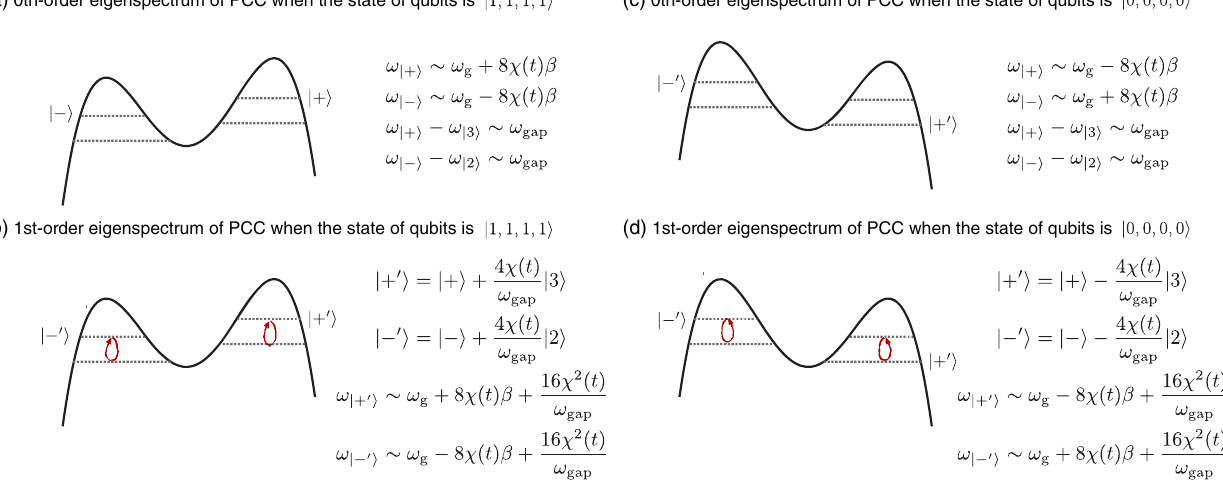
FIG. 15. The figure illustrates the eigenspectrum of the PCO while it is interacting with qubits. The solid line represents the inverted- double-well structure of the metapotential, while the dotted lines represent the energy levels. Recall that j 2 i ∼ D ð − β Þj n ¼ 1 i and j 3 i ∼ D ð β Þj n ¼ 1 i . Unlike the noninteracting case [Fig. 2(b)], the qubit-PCO coupling lifts the degeneracy between jþi and j − i . In other words, the metapotential tilts to the left or right, depending on whether the qubit state is (a) j 1 ; 1 ; 1 ; 1 i or (c) j 0 ; 0 ; 0 ; 0 i . This tilt is the leading-order effect of the interaction, and the energies of the states j(cid:3)i are ω ¼ ω g (cid:3) 8 χ ð t Þ β in (a) and ω ¼ ω g ∓ 8 χ ð t Þ β in j(cid:3)i j(cid:3)i (c). Importantly, if the energy gap is large, then the detuning between jþi , j 3 i and that between j − i , j 2 i remains the same − ω ≃ ω − ω ∼ ω [ ω , in both (a) and (c)]. As shown in Appendix B, the effect of ˆ a † is to couple jþi to j 3 i and j − i to j 2 i . To gap jþi j 3 i j − i j 2 i 3 i , j − 0 i ¼ j − i þ ½ 4 χ ð t Þ = ω 2 i , and ω first order, in (b), jþ 0 i ¼ jþi þ ½ 4 χ ð t Þ = ω ¼ ω g (cid:3) 8 χ ð t Þ β þ ½ 16 χ ð t Þ 2 = ω gap (cid:2) . On the other gap (cid:2)j gap (cid:2)j j(cid:3) 0 i 3 i , j − 0 i ¼ j − i − ½ 4 χ ð t Þ = ω 2 i , and ω hand, in (d), jþ 0 i ¼ jþi − ½ 4 χ ð t Þ = ω ¼ ω g ∓ 8 χ ð t Þ β þ ½ 16 χ ð t Þ 2 = ω gap (cid:2) gap (cid:2)j gap (cid:2)j j(cid:3) 0 i